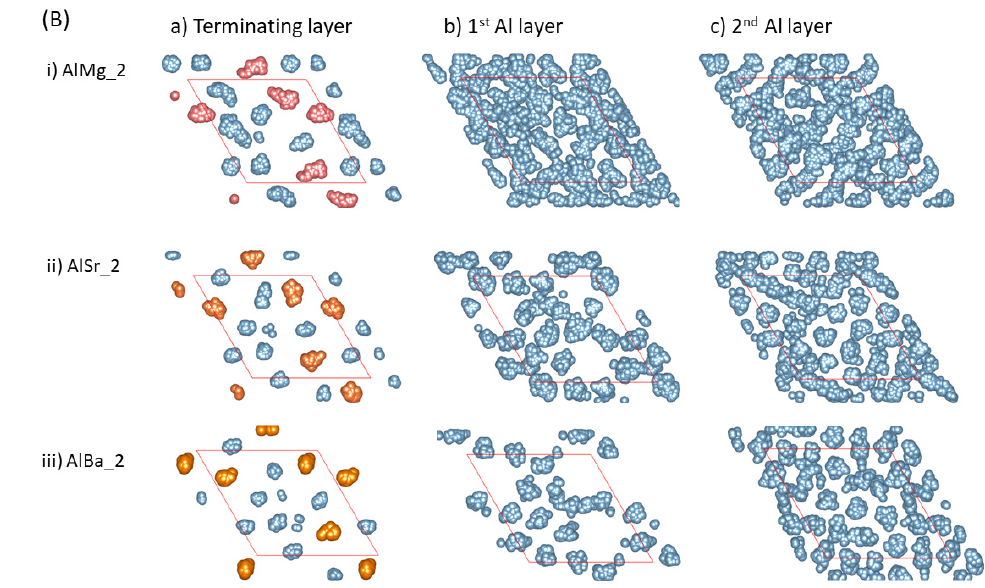
Figure 3. The summed atomic configurations of the terminating Al/AE layer ( a ), the first Al layer ( b ) and the second Al layer ( c ) of the S1 (( A ), top) and S2 (bottom, ( B )) interfaces of L-Al/L-Al/ γ - Al 2 O 3 systems over 3 ps. The silvery spheres represent Al, the dark brown spheres represent O, and the gold spheres represent the AE atoms.